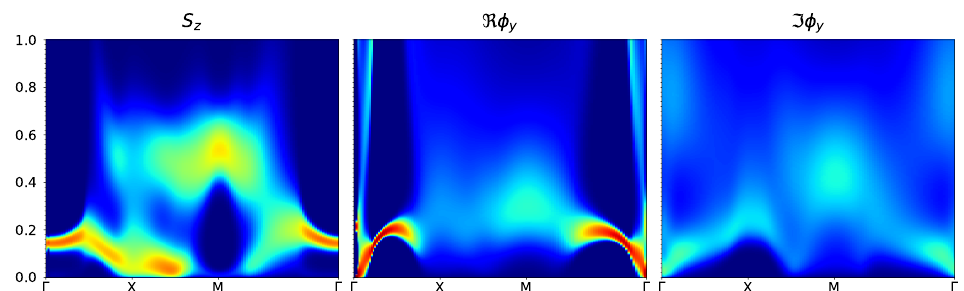
Figure 10: Selected modes of the dynamical susceptibilityy for the two-band Hubbard model described in the text, in the presence of the excitonic condensate, β =